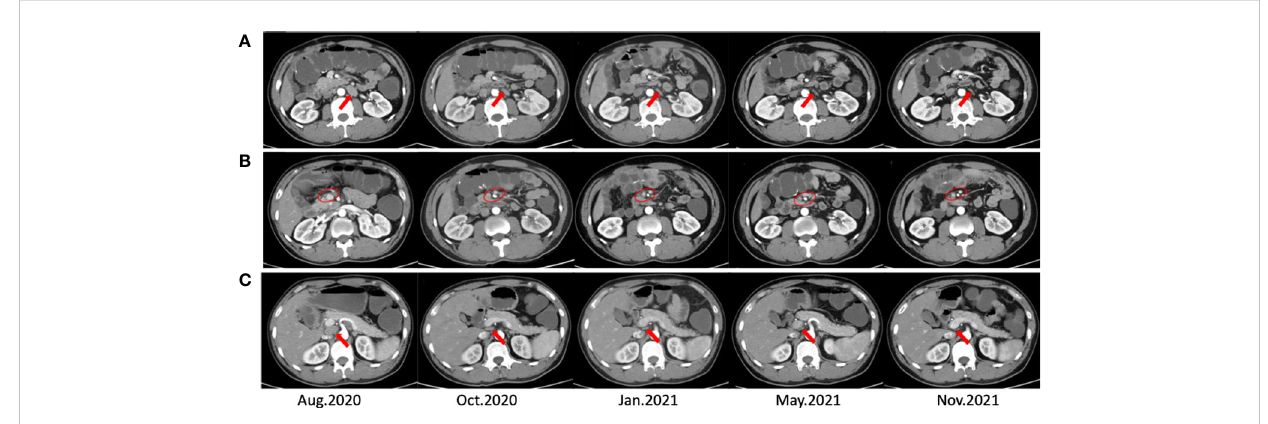
FIGURE 2 CT scans before, during, and after the PRaG therapy. The CT scans (A, B) showed shrunk and disappeared of irradiated lymph node metastases. The CT scans (C) showed shrunk and disappeared of nonirradiated lymph node metastases. The arrows point to individual lymph nodes, and the circles include fusion lymph